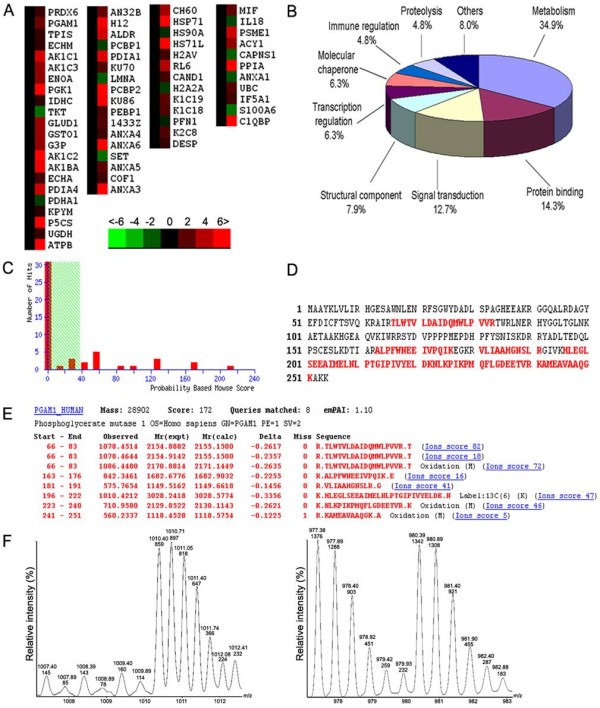
Identification and quantification of proteins by LC-MS/MS Based on SILAC method. (A) Clustering analysis of the identified proteins from L02 cells and HepG2 cells. Protein cluster map generated by Cluster software. Expression of proteins in the normal group was constant at 0, proteins up-regulated in cancer tissue were in red, and the down-regulated proteins were in green. The intensity of the color green or red corresponds to the degree of alteration, respectively, according to the color strip at the bottom of the figure. These data were derived from three independent analyses. (B) A total of 63 dysregulated proteins were classified into 11 groups with diverse functions including metabolism (34.9%), signal transduction (12.7%), structural component (7.9%), and other functions (44.5%). (C), (D), and (E) showed output of the LC MS/MS database using the MASCOT program. LC MS/MS analysis revealed 8 matched peptides with 38% sequence coverage and a MOWSE score of 172. The matched peptides were shown in bold red. (F), left, MS spectrum showed a SILAC peptide matching PGAM1, with an up-regulation up to 6-fold. The m/z presents a difference of 3 mass units between labeled and unlabeled peptide pair, resulting in a 2+ change state; right, control SILAC peptide from β-actin.